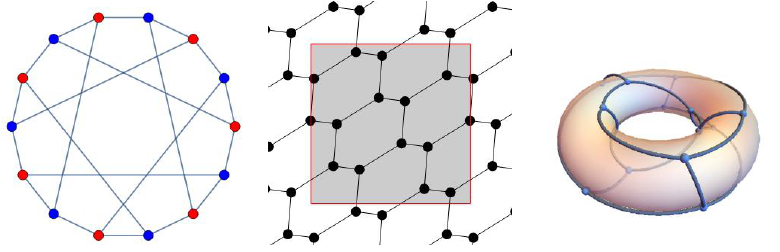
Figure 7. The drawings of the Heawood graph.